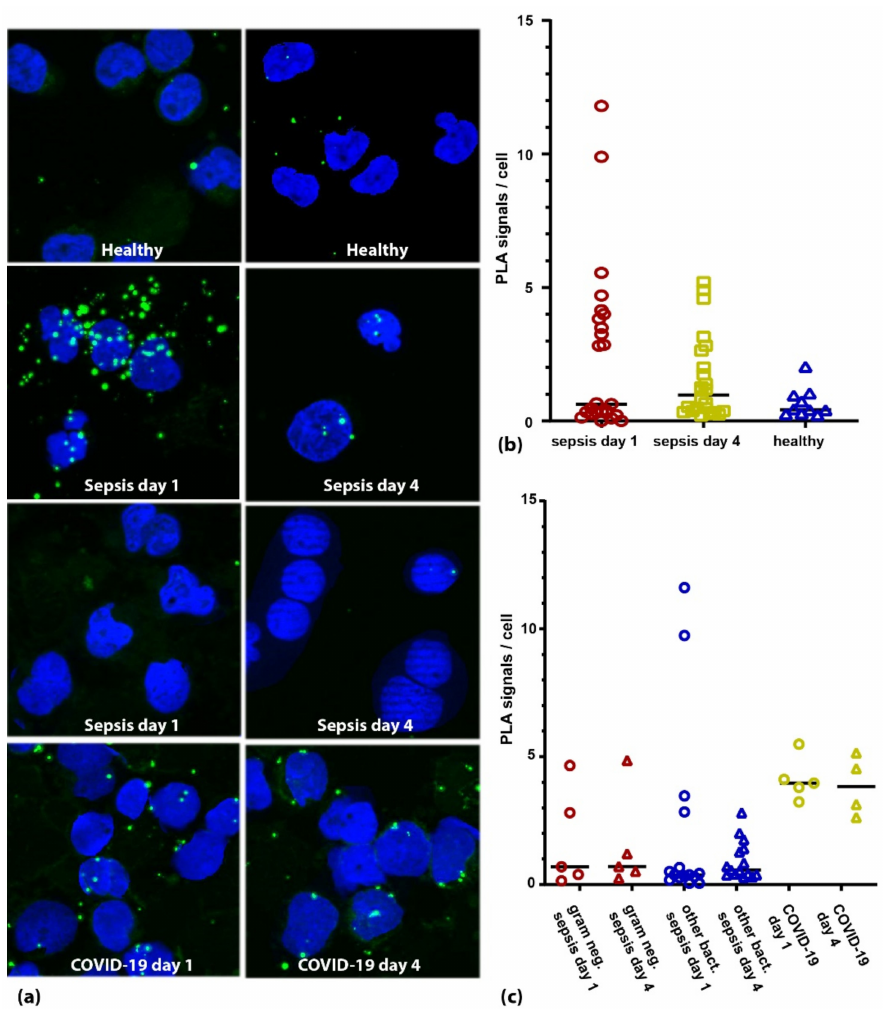
Figure 3. TLR4 activation in PBMCs from sepsis patients. ( a ) Microscopic images of two healthy individuals ( upper panel ), two sepsis patients (panels 2 and 3) and one COVID-19 patient ( lower panel ) at day 1 and day 4 after study inclusion. Nuclei are shown in blue; PLA signals are depicted as green dots. ( b ) Quantification of the TLR4 activation in critically ill patients (bacterial sepsis and COVID-19) at days 1 (red symbols) and 4 (yellow symbols) in comparison to healthy individuals (blue symbols). ( c ) When analyzing the TLR4 activation based on the pathogen of the suspected primary infection, we find no obvious association with gram status (gram negative patients shown in red symbols, other bacterial sepsis patients shown in blue symbols). Strikingly, COVID-19 patients (yellow symbols) showed higher activation than patients with bacterial sepsis both at day 1 and day 4 ( p = 0.015 and p = 0.001 respectively, Mann–Whitney U